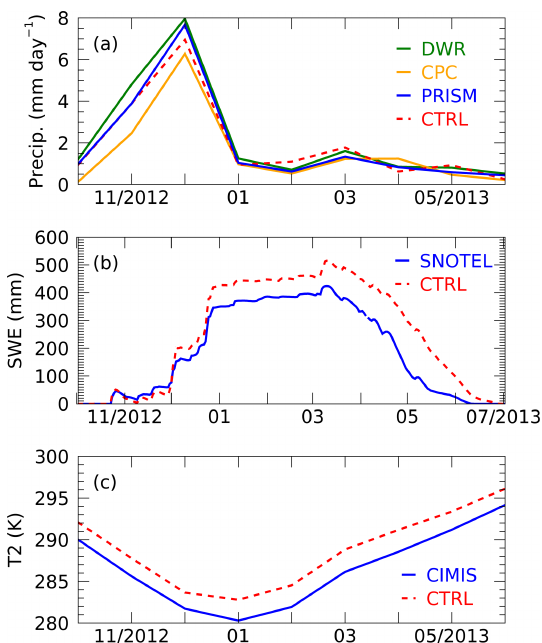
Figure 3. (a) Monthly mean precipitation (mmday − 1 ) from the CTRL simulation (red dashed) and PRISM (blue), CPC (orange), and DWR (green) observations. (b) Daily accumulated SWE (mm) from the CTRL simulation (red dashed) and SNOTEL observation (blue). (c) Monthly mean T2 (K) from the CTRL simulation (red) and CIMIS observation (blue). Model data are sampled onto obser- vational sites before the comparison is